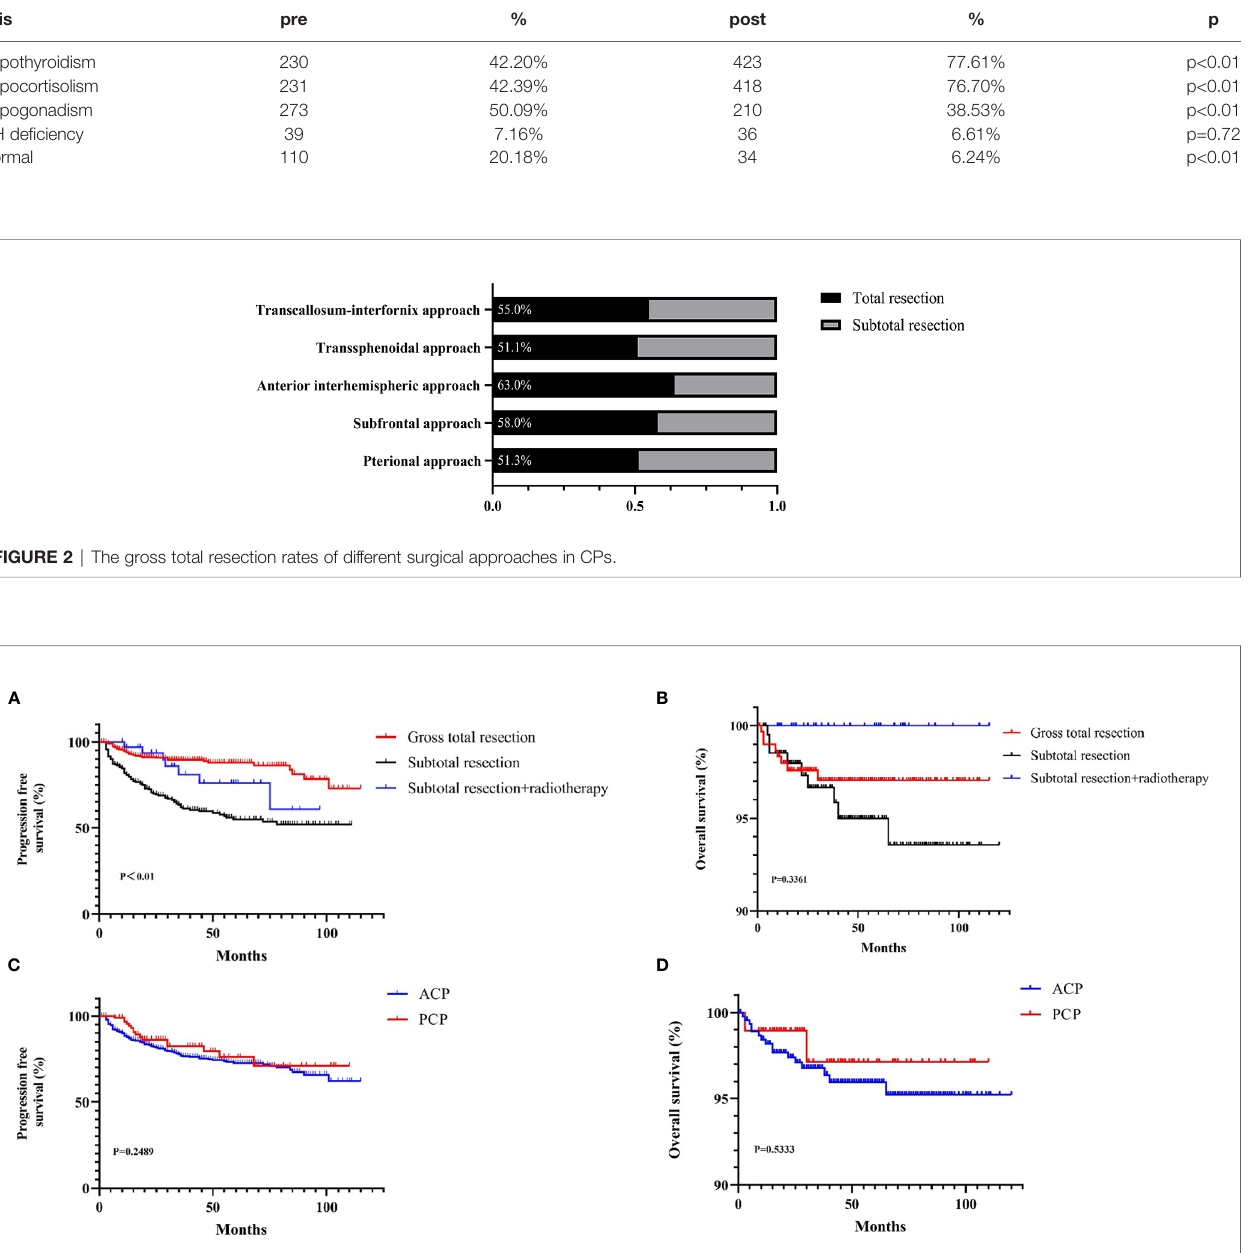
FIGURE 3 | The KM curves for Survival curves for the patients with or without adjuvant treatment (A, B) and pathological type (C, D) .